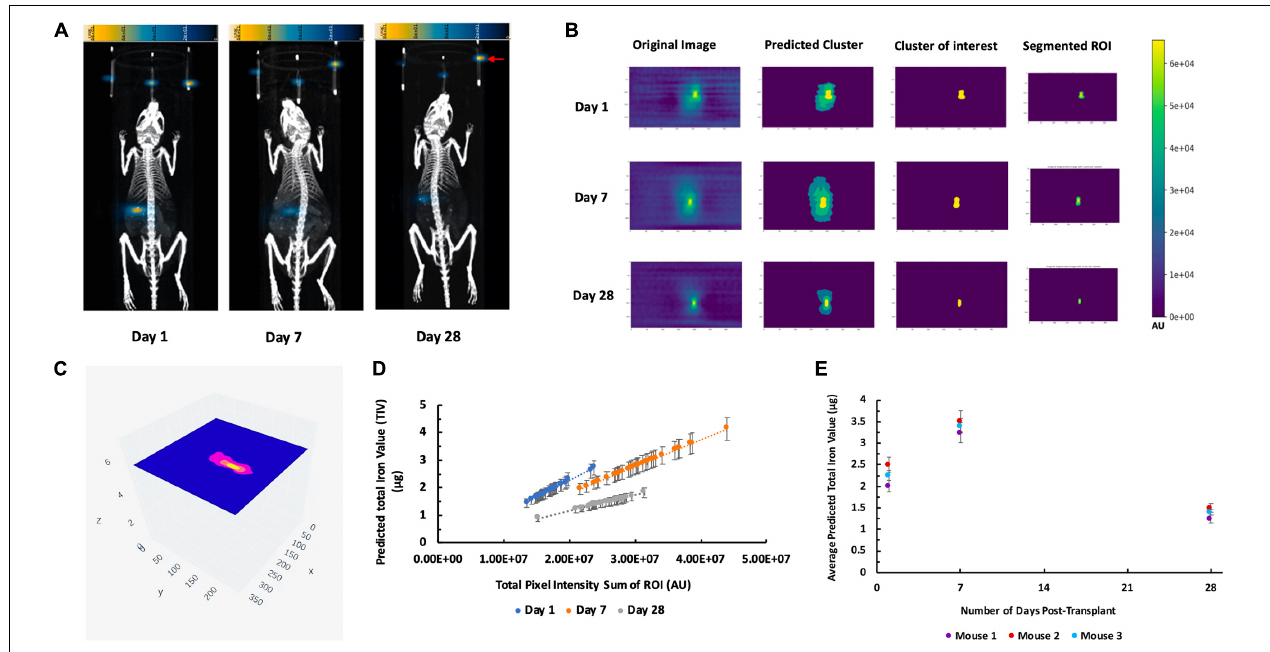
FIGURE 6 | K-means ++ segmentation and TIV prediction of longitudinal MPI of mice transplanted with islet organoids under the left kidney capsule. (A) Representative 3D MPI of mice days 1, 7, and 28 post Tx, all animals were placed in the prone position for both MPI and CT scanning. Red arrow shows the fiducial markers embedded in the animal scanning holder. (B) Single-slice output K-means ++ segmentation of MPI ROI generated from original images through predicting clusters in MPI of recipient mice 1, 7, and 28 days post TX; Form left to right: original DICOM of 3D MPI; predicted clusters from K-means ++ algorithm; mask of the predicted cluster of interest; real segmentation of original MPI using predicted mask. (C) Representative 3D volumetric rendering of K-means ++ predictions of MPI ROIs on slices from a mouse post Tx. (D) TIV predictions from algorithm indicates a correlation between increasing total pixel sum per slice and the machine learning-generated TIV of days 1, 7, and 28 post Tx ( p < 0.05). (E) Average of the TIV in the organoid transplants from days 1, 7, and 28 post transplantation in mice. Data are represented as mean ± SD ( p < 0.05).